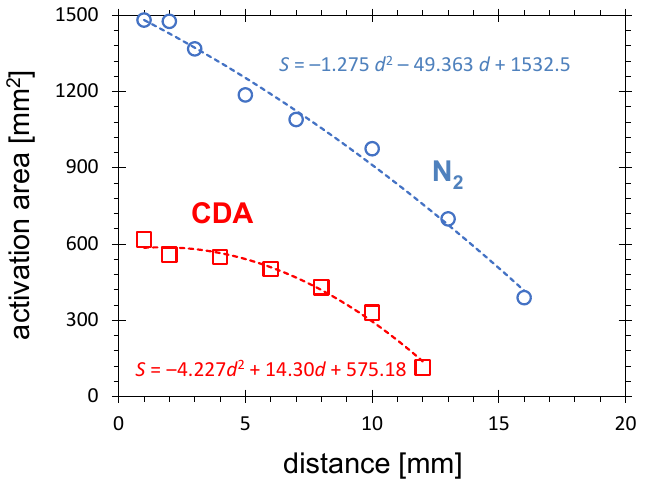
Figure 5. The activation area after N 2 or CDA PDD treatment as a function of distance between the PCPG tip and the HDPE substrate for the gas flow of 8.0 SLM, the treatment time of 10 s, and the PCPG input power of 8.0